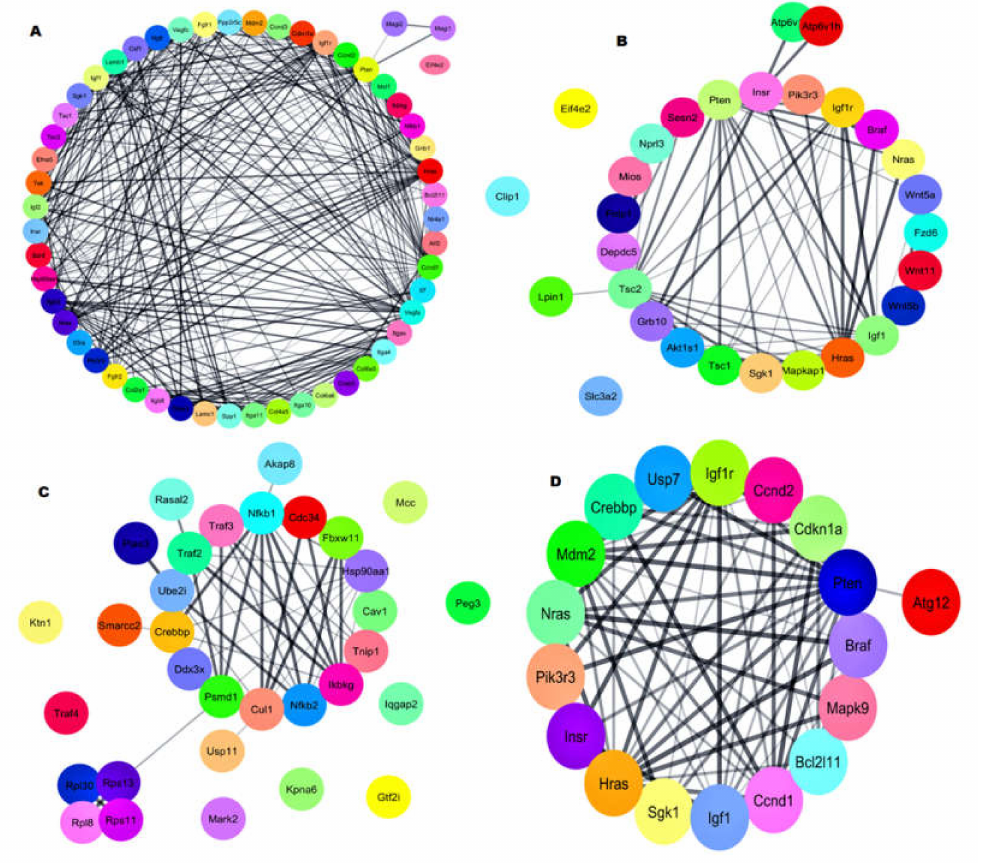
Figure 5. Gene–gene interaction network analysis. ( A ) PI3K-Akt signaling pathway genes network, ( B ) mTOR signaling pathway genes network, ( C ) TNF-alpha NF- κ B Signaling Pathway genes network, and ( D ) FoxO signaling pathway genes